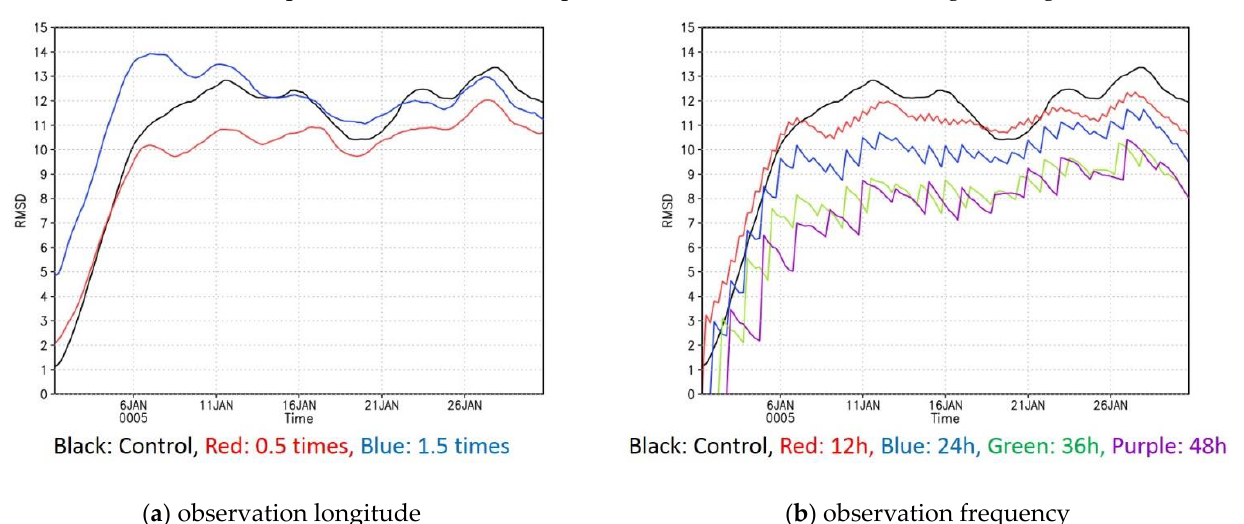
Figure 8. Root-mean-square deviations (RMSD) of zonal wind (m/s) calculated by Equation (4) at 70 km in each assimilated case from 1 January, 5th year. Dependency on the range of ( a ) observation longitude and ( b ) observation frequency. In ( a ), observation longitudes are half (red line) and 1.5 times (blue line) of the control case with 120° (black line). In ( b ), observation frequencies are 12-Earth-hourly (red line), 24-Earth-hourly (blue line), 36-Earth-hourly (green line), and 48-Earth- hourly (purple line) compared with the control case with a 6-Earth-hourly (black